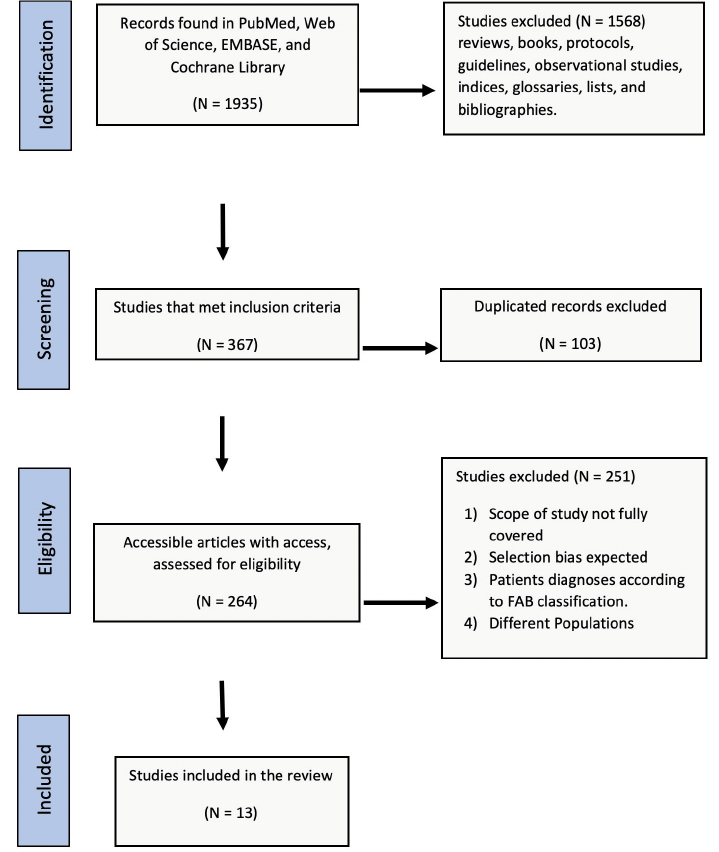
Figure 1. PRISMA fl owchart of the literature review. Figure 1. PRISMA flowchart of the literature